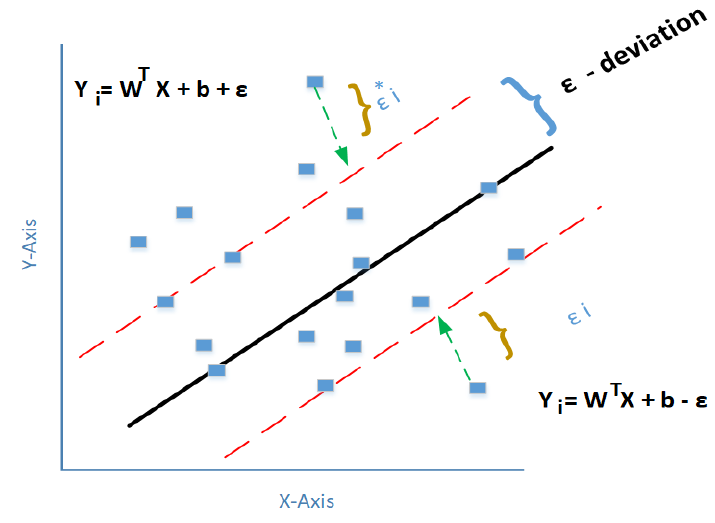
Figure 1. Support vector regression model.